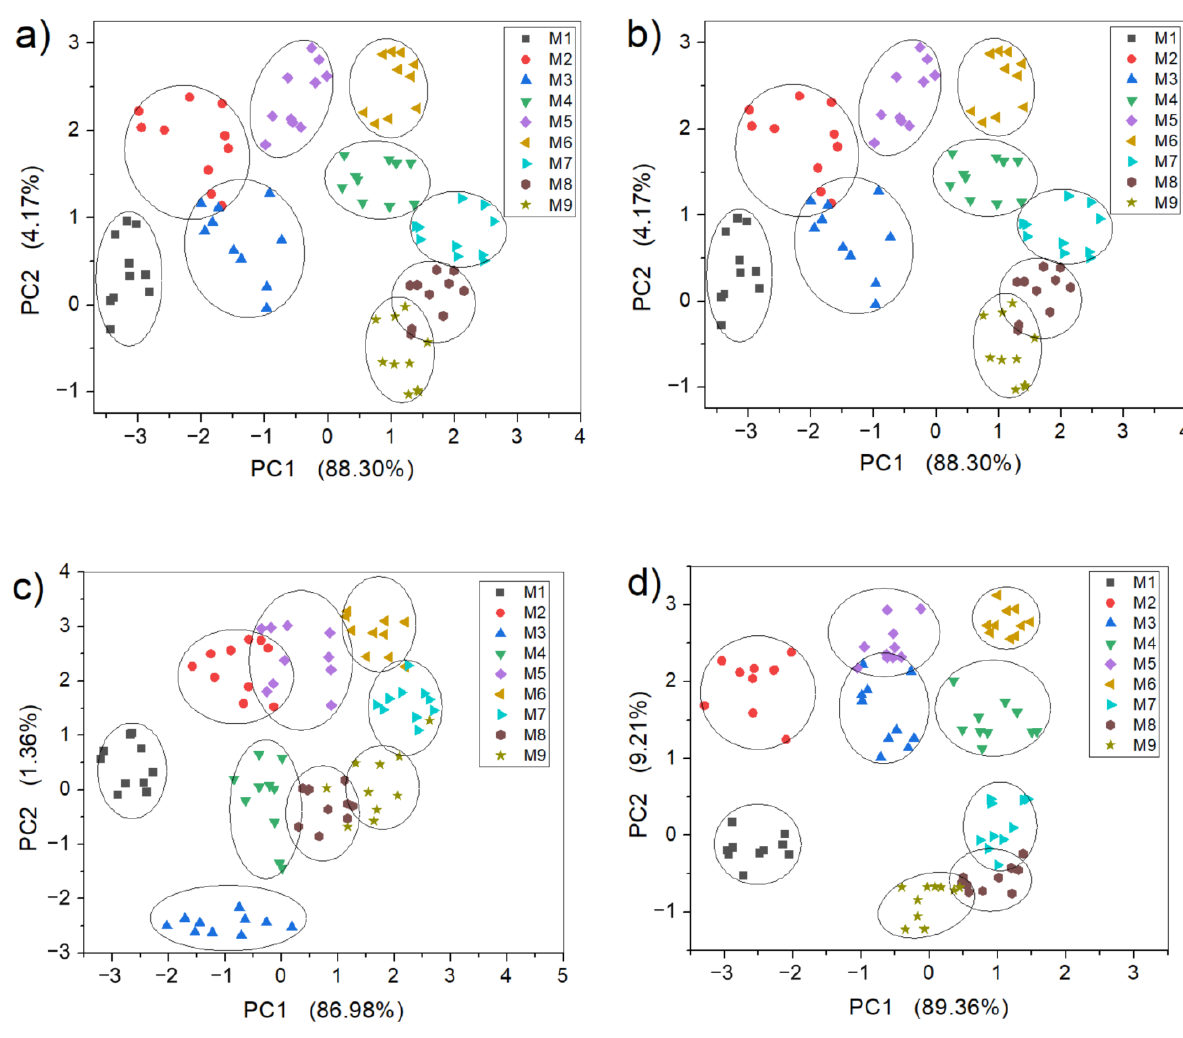
Figure 11. PCA analysis of gas features extracted by E-nose with sensor array optimized based on a single evaluation indicator: ( a ) sensitivity, ( b ) selectivity, ( c ) correlation, and ( d ) repeatability.